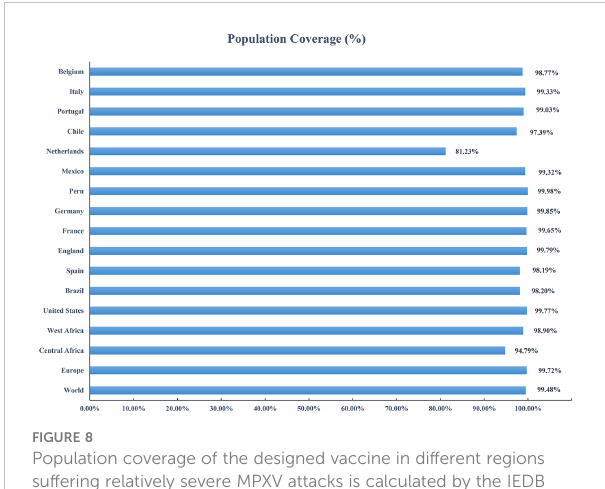
FIGURE 8 Population coverage of the designed vaccine in different regions suffering relatively severe MPXV attacks is calculated by the IEDB population coverage tool.